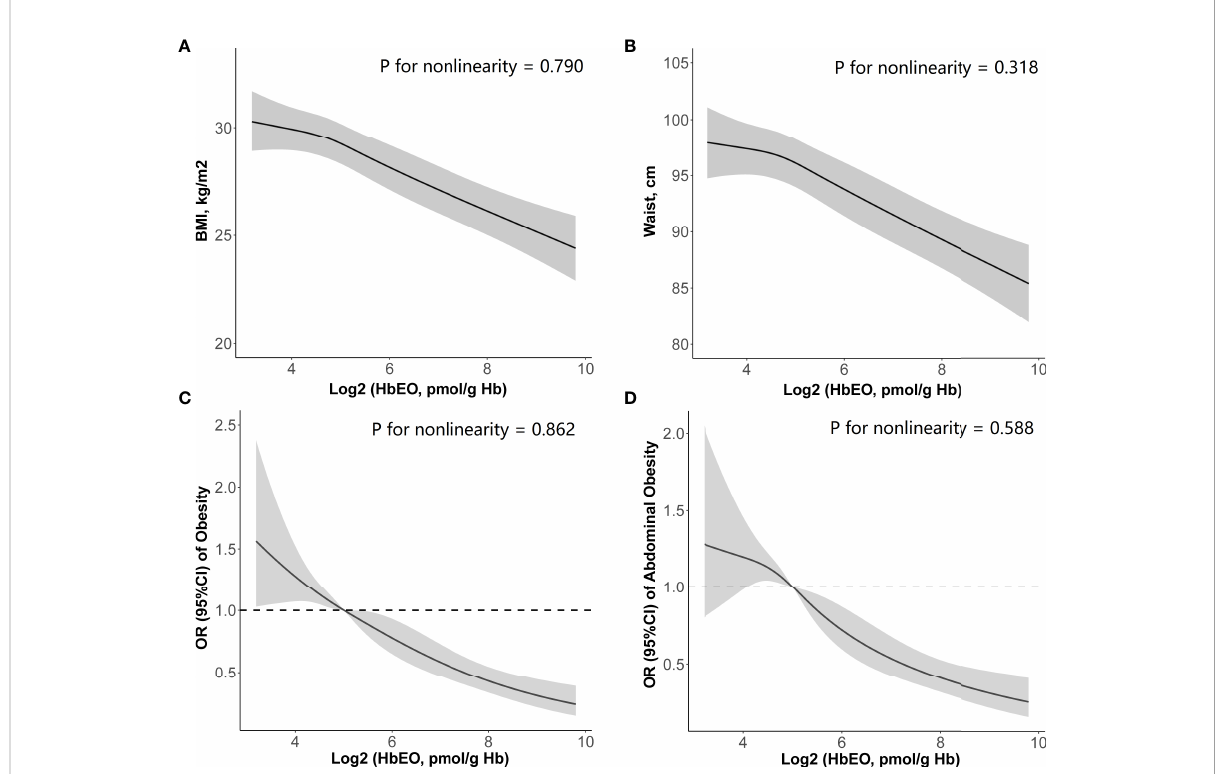
FIGURE 2 Restricted cubic spline (RCS) plots of the association of HbEO levels with (A) body mass index, (B) waist circumference, (C) prevalence of obesity, and (D) prevalence of abdominal obesity. Adjusted for age, sex, education level, race, poverty, smoker, alcohol user, energy intake levels, sedentary time, total cholesterol, high-density lipoprotein cholesterol, diabetes, and hypertension. HbEO, hemoglobin adduct of ethylene oxide; BMI, body mass